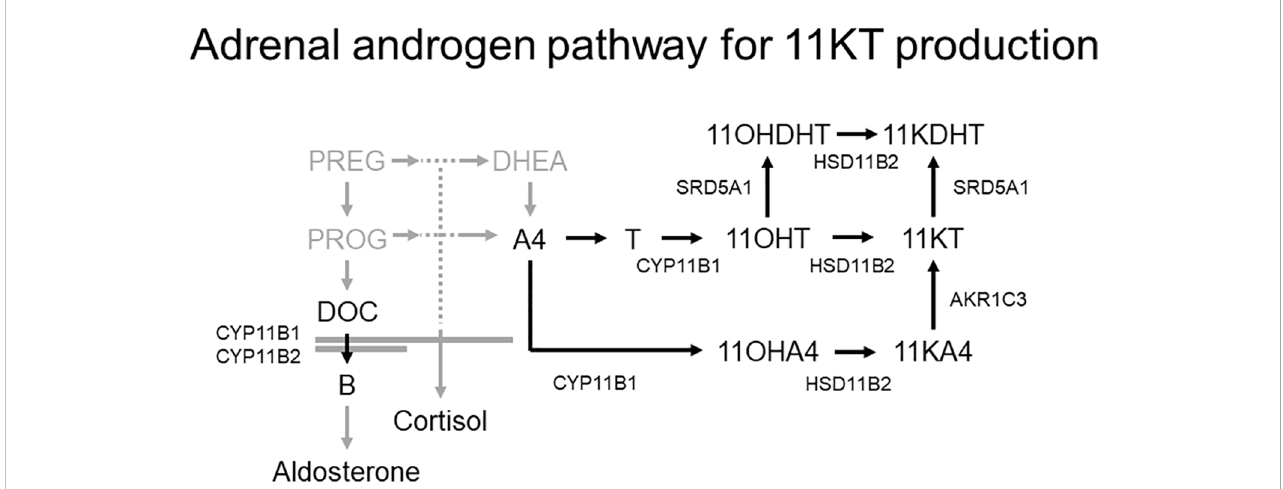
FIGURE 1 Adrenal androgen pathway for 11KT production (6). Two pathways produce 11KT; one involves the conversion of testosterone to 11OHT, and the other involves the conversion of A4 to 11KA4 via 11OHA4. The conversion of testosterone and A4 to 11OHT and 11OHA4, respectively, is catalyzed by CYP11B1, and the subsequent conversion of 11OHT and 11OHA4 to 11KT and 11KA4, respectively, is catalyzed by